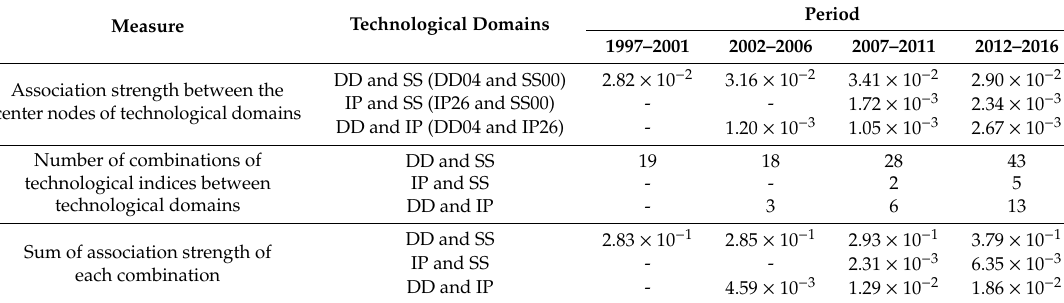
Table 3. Technological relatedness between technological